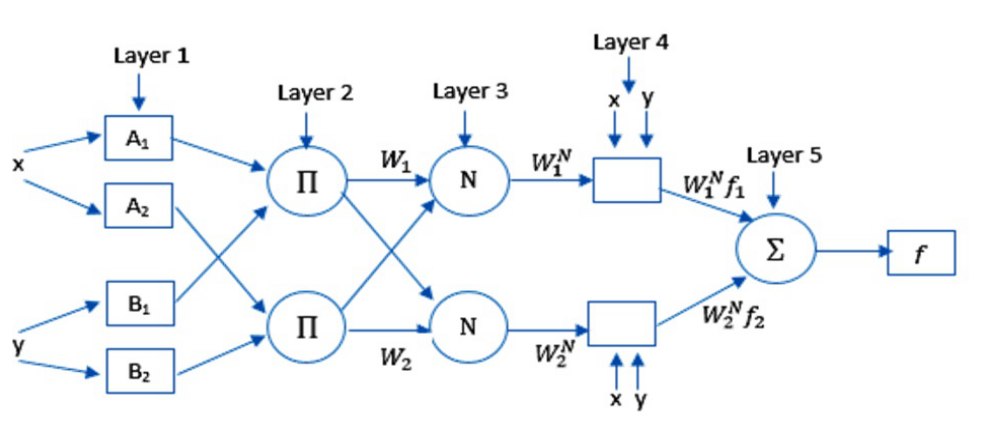
Figure 1. ANFIS model